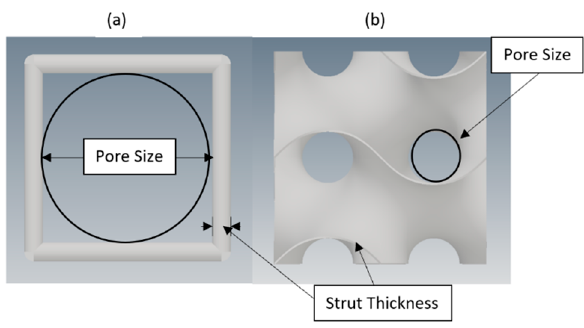
Figure 2. Unit cell pore size and strut thickness for: ( a ) cube; and ( b ) gyroid.